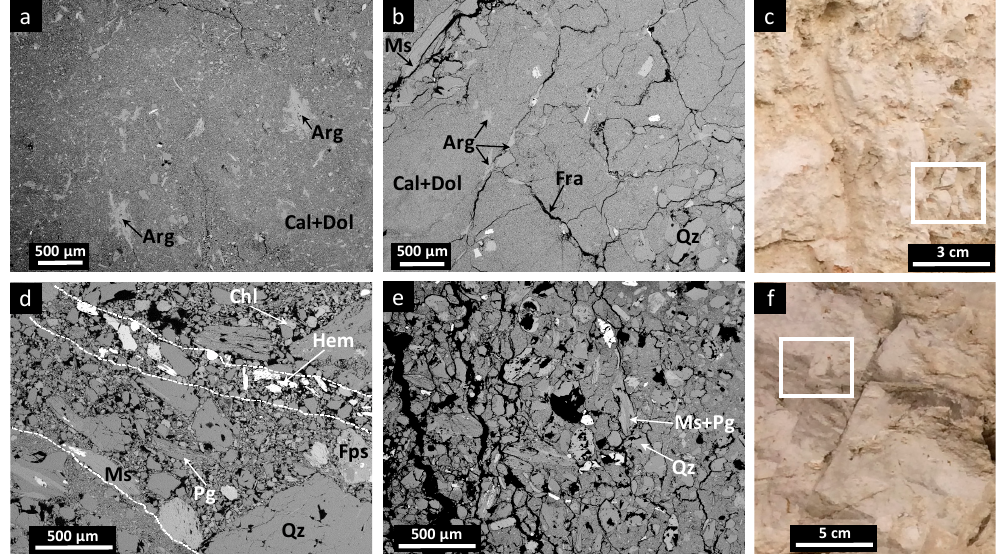
Figure 13. Petrography of samples from the damage zones of the Baza Fault. ( a , b ): Carbonatic lithofacies made of a micritic matrix of dolomite and calcite with a disconnected fracture network filled by aragonite (Altichuelas site). ( c ) Outcrop picture showing the macroscopic fractures of the sample; square indicates the area of the SEM images ( a ) and ( b ). ( d , e ) Detrital silicate deformation bands made of quartz, alkali feldspars, Fe oxides / hydroxides and phyllosilicates (muscovite, paragonite, chlorite) (Carrizal site). ( f ) Outcrop picture showing the macroscopic fractures of the sample; square indicates the area of the SEM images ( d ) and ( e ). Cal: Calcite, Dol: Dolomite, Arg: Aragonite, Qz: Quartz,